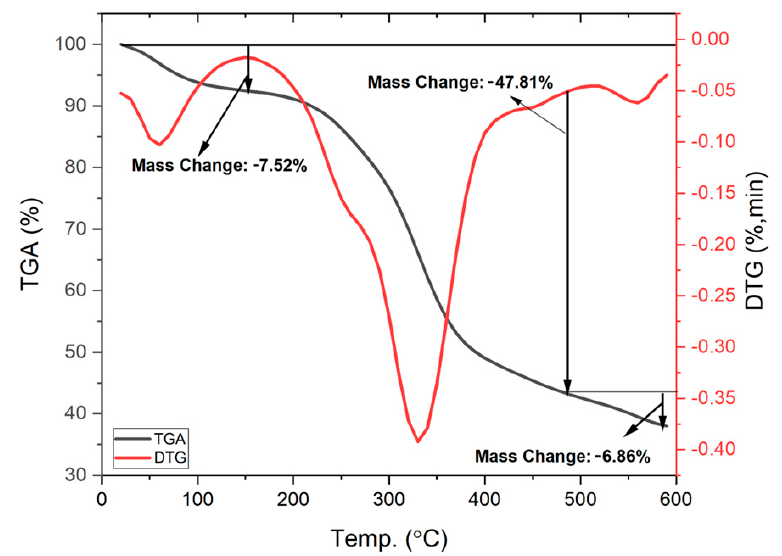
Figure 4. TGA curve of PCD-zeolite-IB.